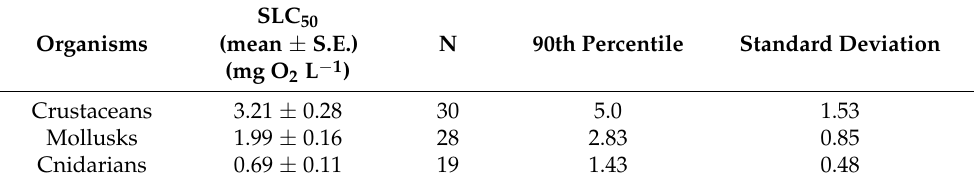
Table 2. Median sublethal concentrations (SLC 50 , mg O 2 L − 1 ) and the 90th percentile thresholds for hypoxia in Crustacea, Mollusca, and Cnidaria provided by Vaquer-Sunyer and Duarte [5]. SLC 50 Organisms (mean ± S.E.)